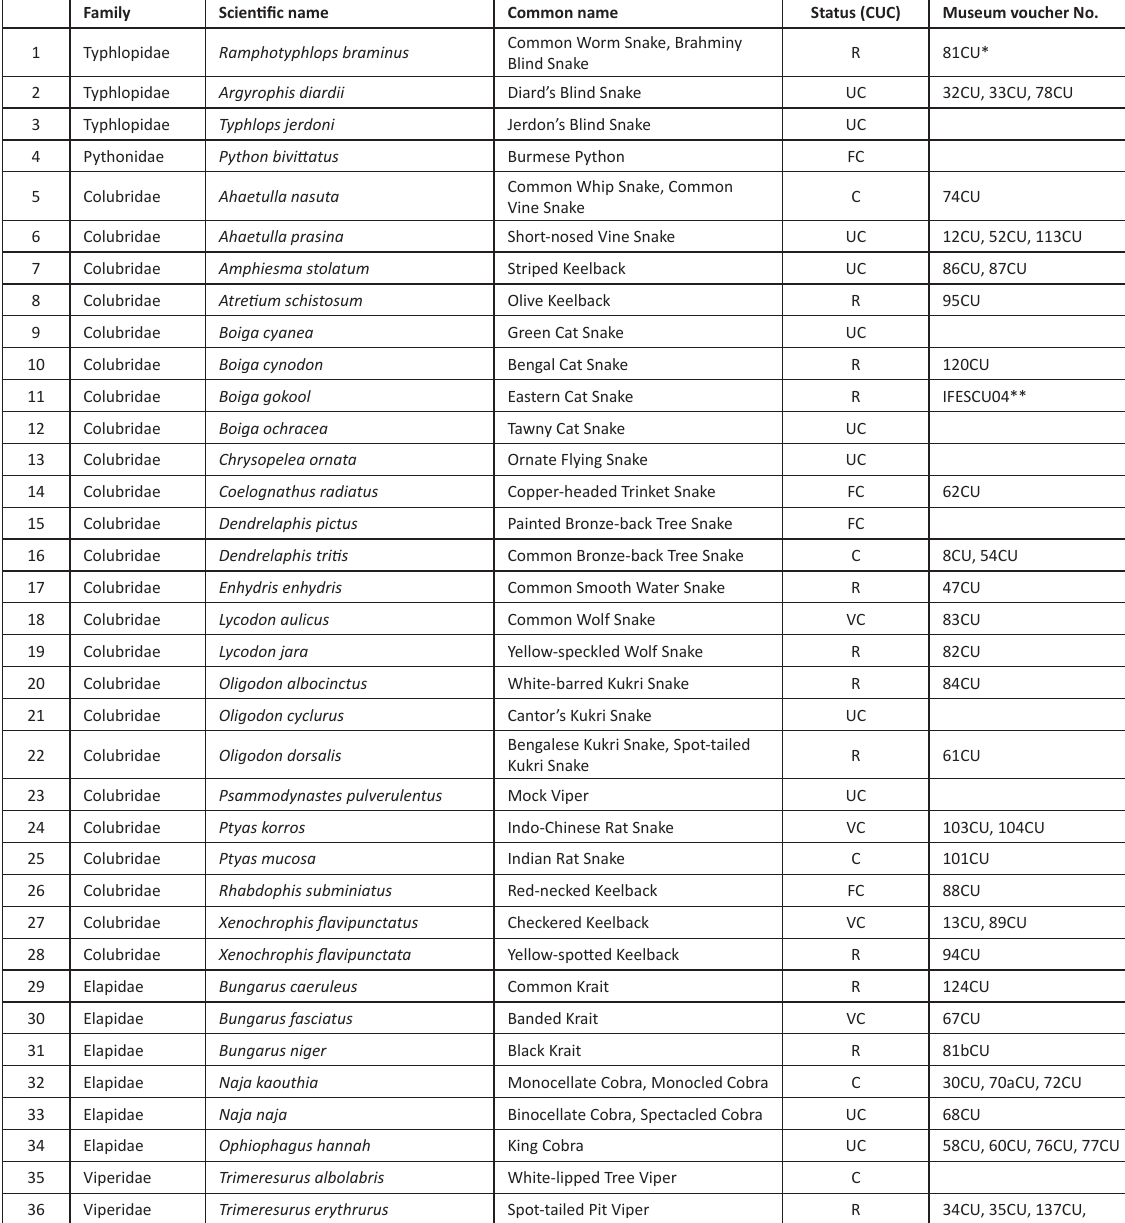
Table 1. List of snakes of the Chittagong University Campus,